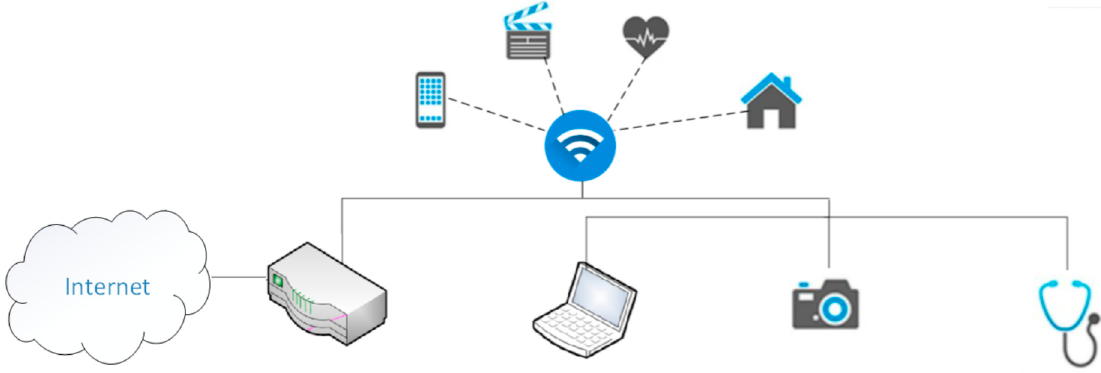
Figure 1. IoT network model.